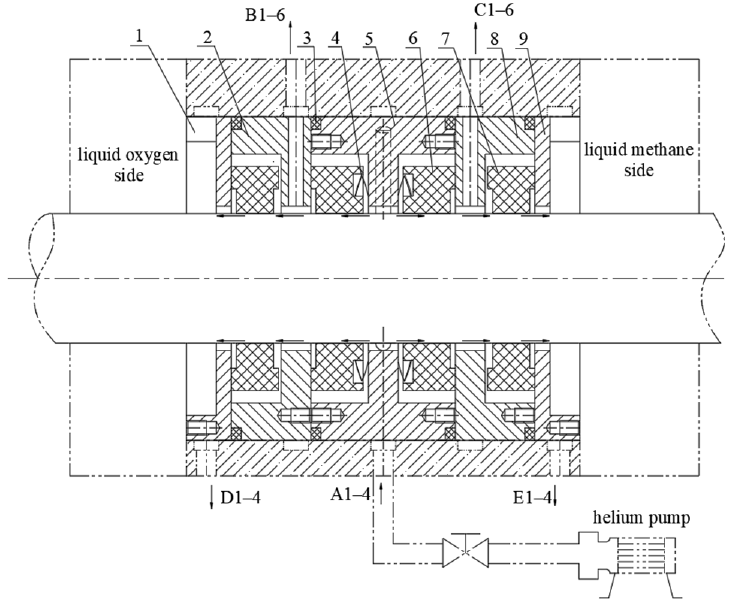
Figure 2. Two-dimensional diagram of the two-stage floating-ring isolation seal structure (1. seal outer cavity B, 2. seal inner cavity B, 3. gasket, 4. wave spring, 5. seal middle cavity A, 6. primary floating ring, 7. secondary floating ring, 8. seal inner cavity A, and 9. Seal outer cavity A).